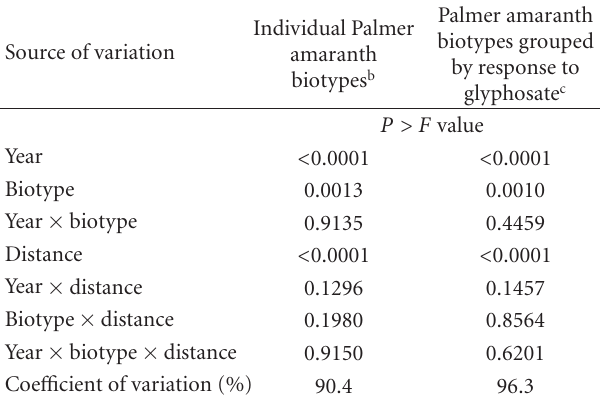
Table 2: P > F for percent reduction in soybean yield caused by season-long interference by Palmer amaranth in field experiment. a